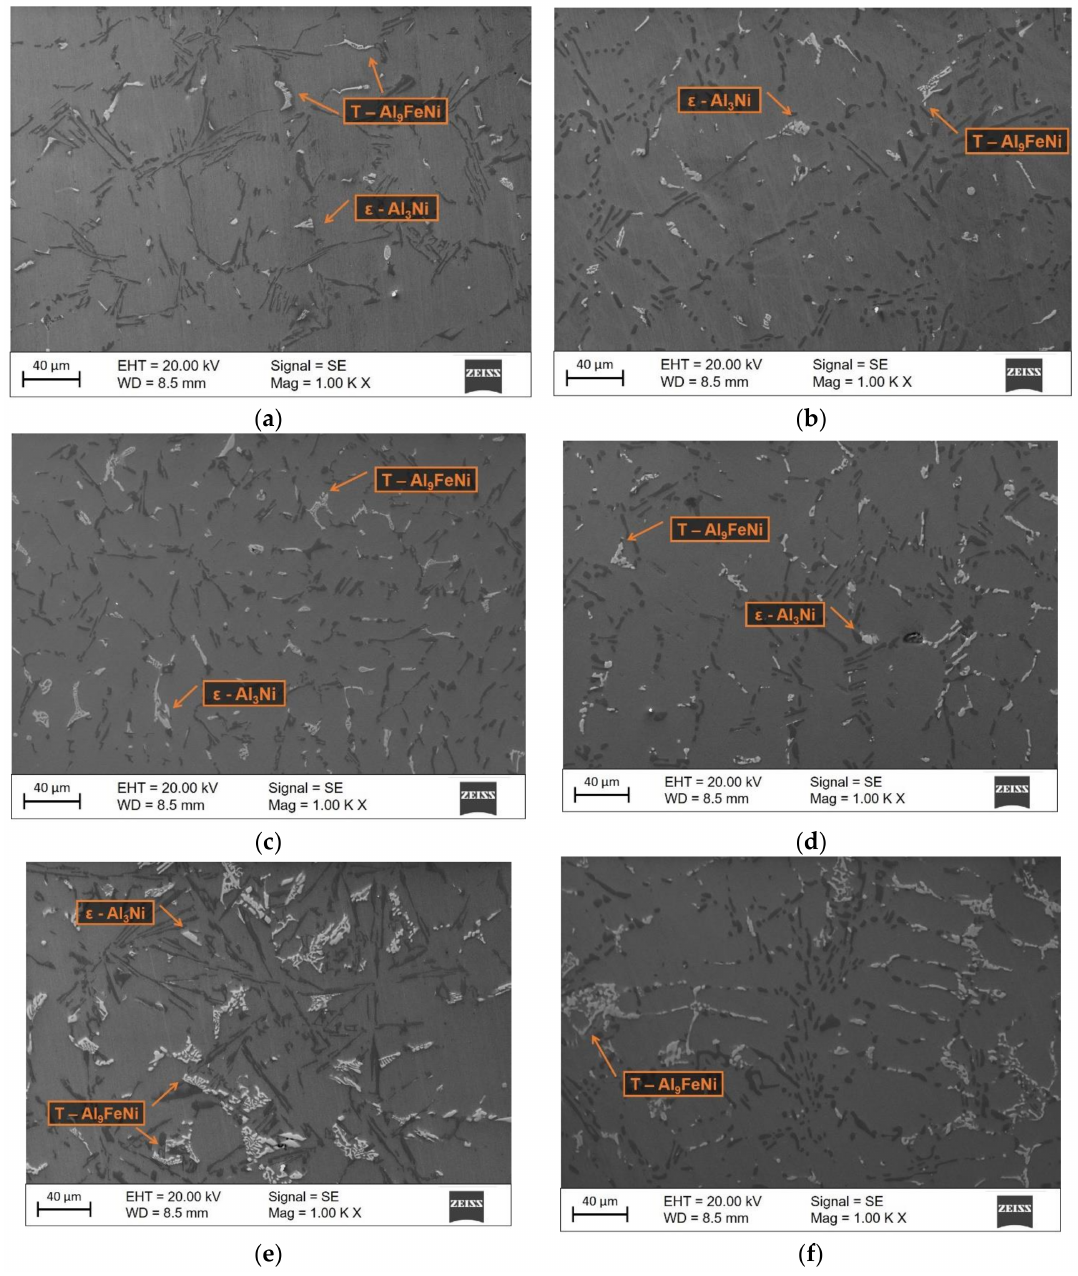
Figure 3. SEM micrographs (secondary electron images) of the alloys containing 0.5 ( a , b ); 1 ( c , d ) and 2 wt % Ni ( e , f ): ( a , c , e ) as-cast condition; and ( b , d , f ) T6